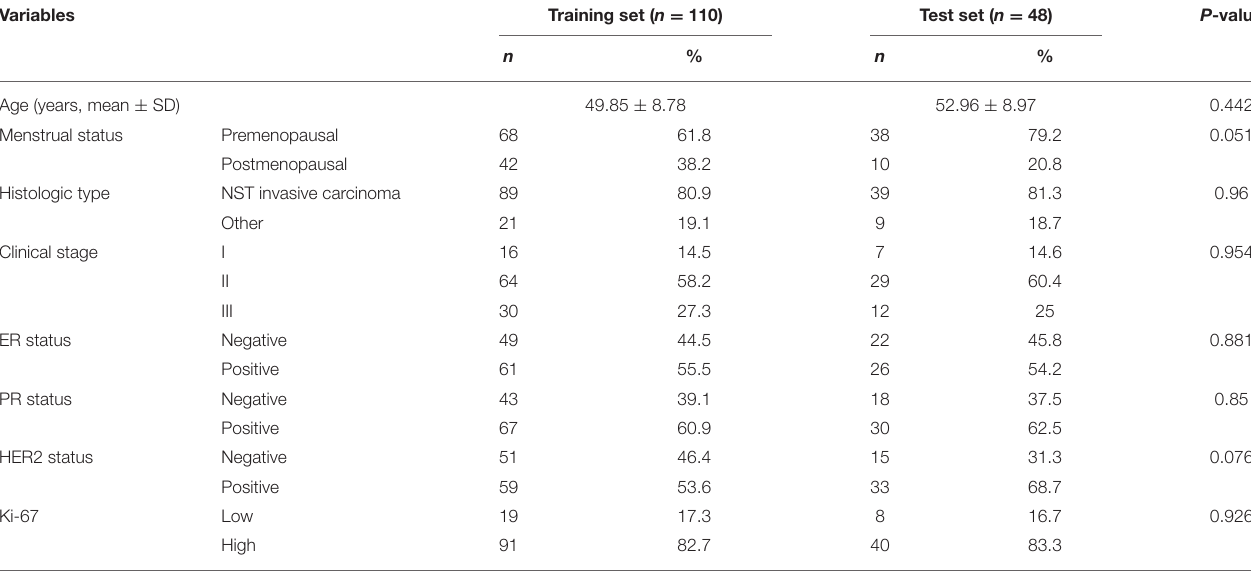
TABLE 1 | Clinical characteristics of patients in the primary and internal validation cohorts.